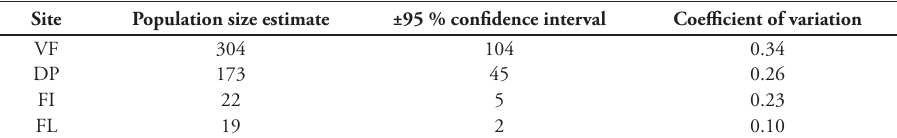
Table 7. Estimation of population size. O. eremita population size estimates obtained by monitoring during 2015 in the two macroareas PA and FC (PA= Parco Nazionale d’Abruzzo Lazio e Molise; FC = Foreste Casentinesi; VF = Val Fondillo; DP = Difesa di Pescasseroli; FI = Feudo Intramonti e Colle di Licco; FL = Foresta della Lama).